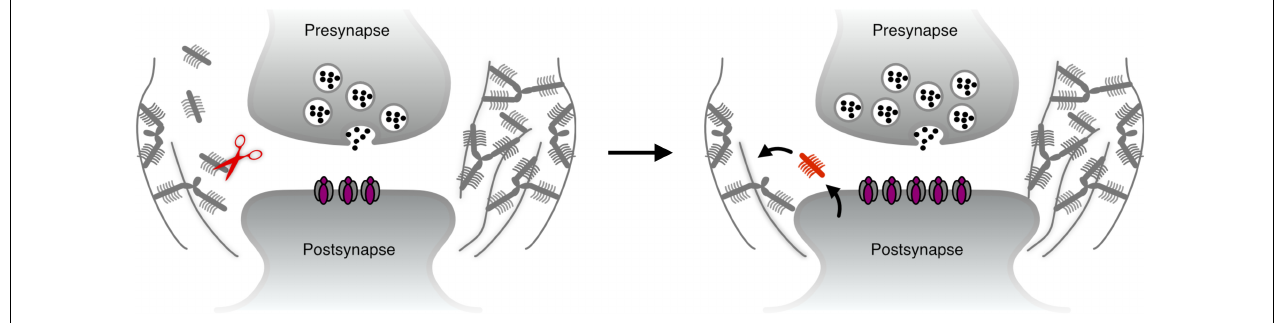
FIGURE 1 | The dominant paradigm for ECM remodeling – proteolytic cleavage. Left: when synaptic plasticity is initiated, ECM cleaving proteases such as MMP9 (Michaluk et al., 2011) may be translated and/or secreted locally at the synapse. Right: the synapse undergoes structural plasticity, and new molecules are secreted to re-stabilize the perisynaptic